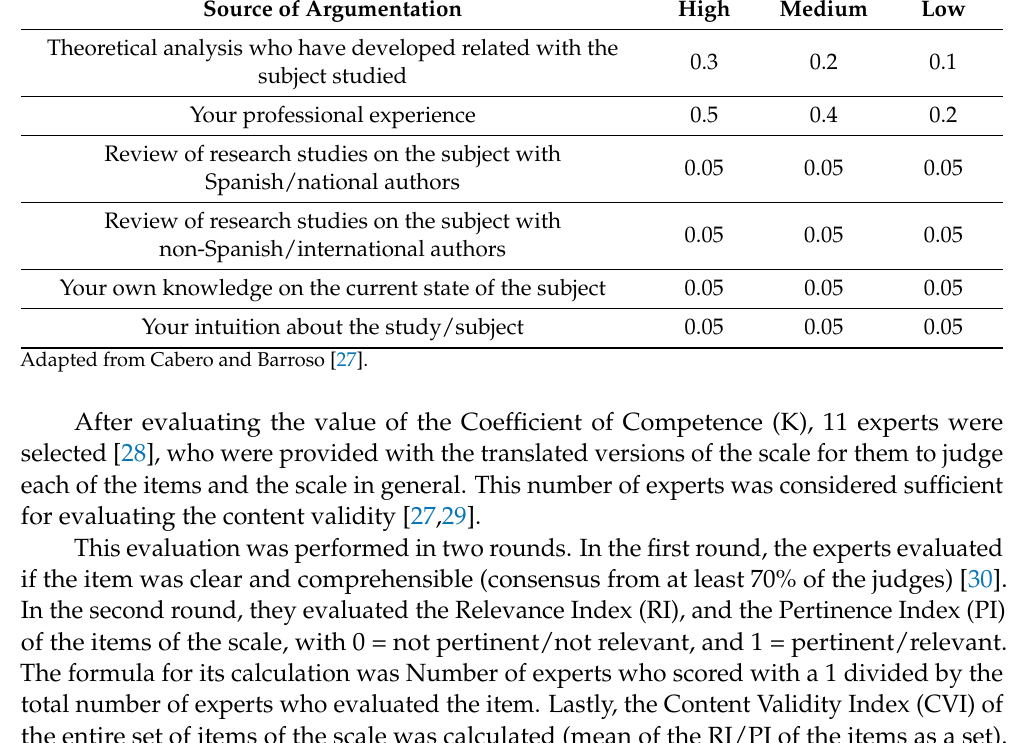
Table 1. Scores of the sources of argumentation to obtaining the “Argumentation coefficient” (Ka). Source of